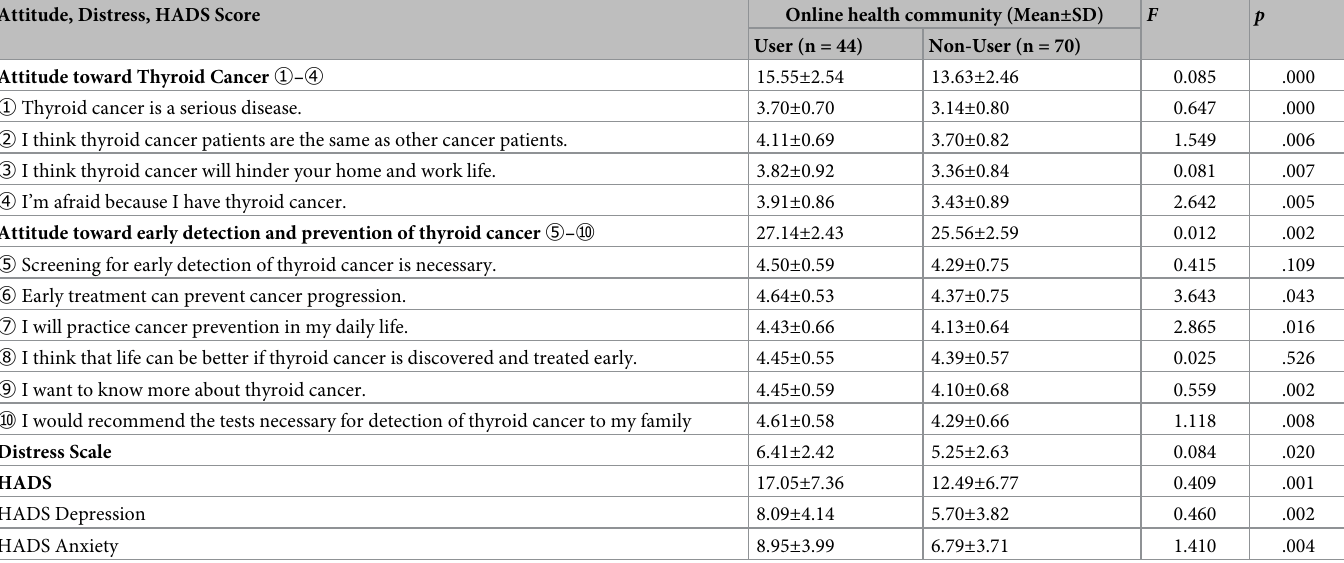
Table 3. Attitude, distress & HADS scores of online health community users and non-users (n = 114). Attitude, Distress, HADS